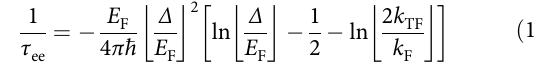
in Fig. 1e, R I for large | V E | (e.g., the red curve) is larger than that for small | V E | (black) for the condition V CG ≥ V UG ( = 3.87 V). This indicates that the total momentum of the electron system at the T-branch region is non-zero and directed to the collector.